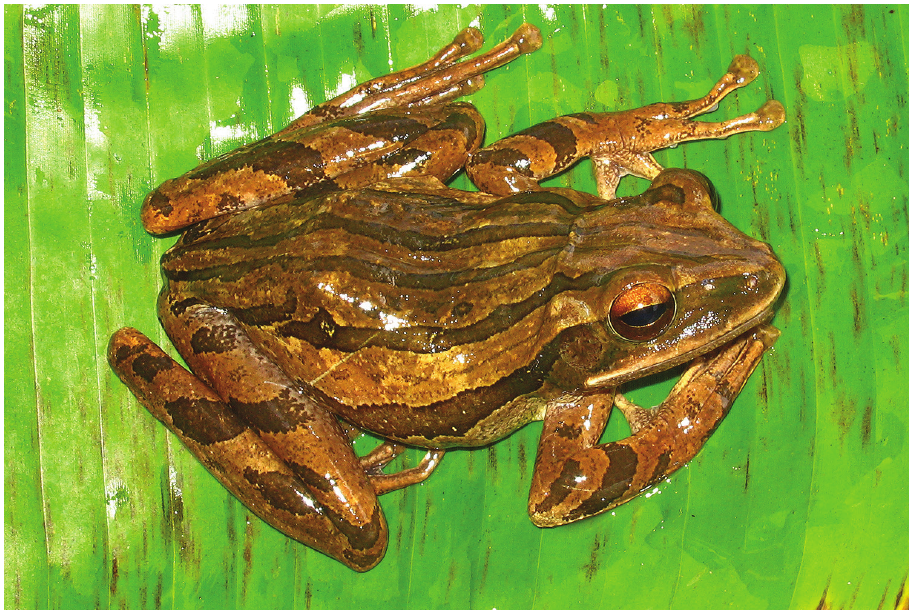
Figure 34. The frog Polypedates leucomystax is represented in the Philippines by at least two highly divergent mitochondrial gene lineages (Brown et al. 2010); one, shown here, is widely distributed from northern Luzon to northern Mindanao. Photo: K. Hesed (from Isabela Province, Luzon; KU